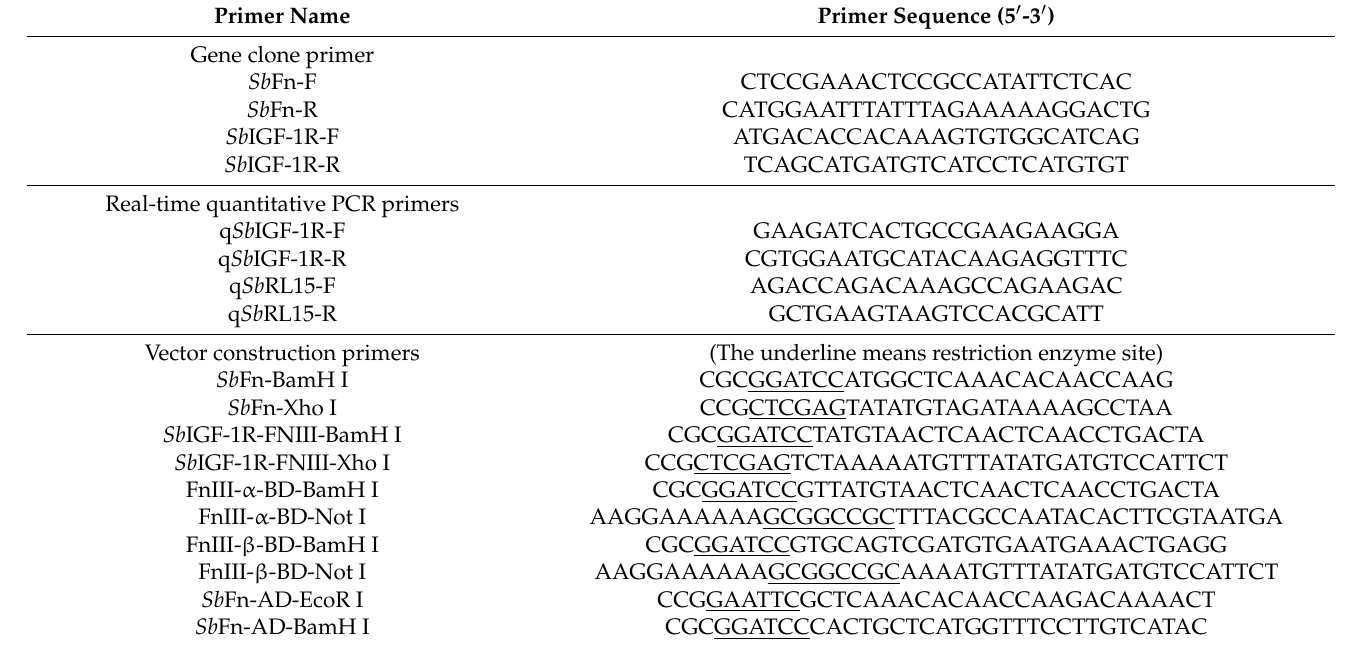
Table 1. The sequences utilized in this